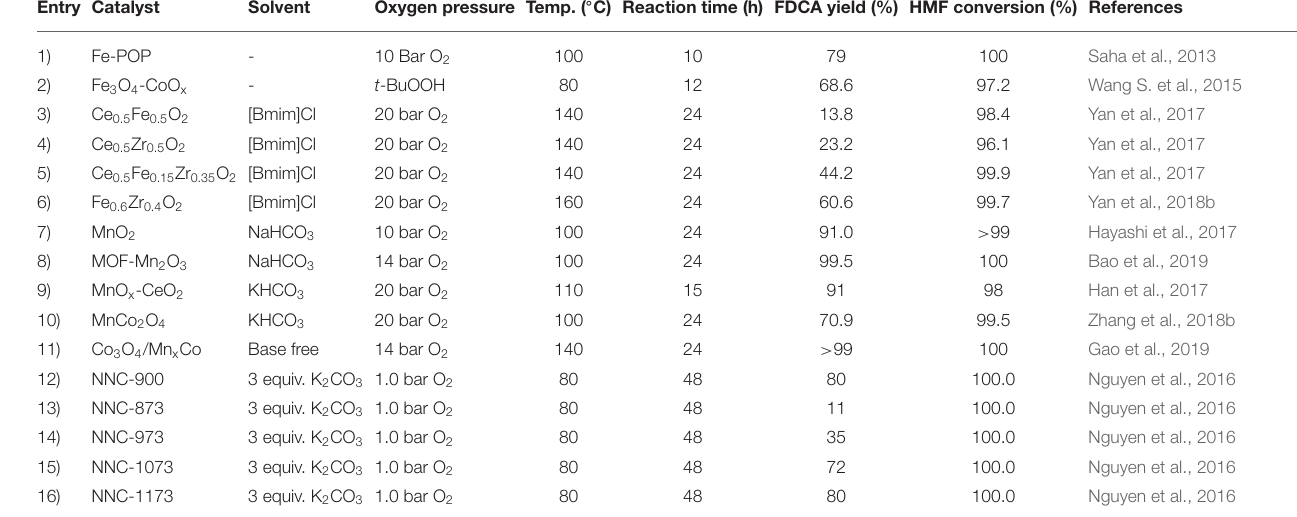
TABLE 3 | Aerobic HMF oxidation to FDCA over non-noble and metal-free catalysts. Entry